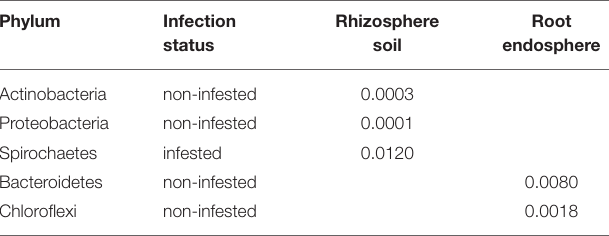
TABLE 2 | Comparison of relative abundance of bacterial communities between treatments within each infested/non-infested group tested by Kruskal-Wallis test.